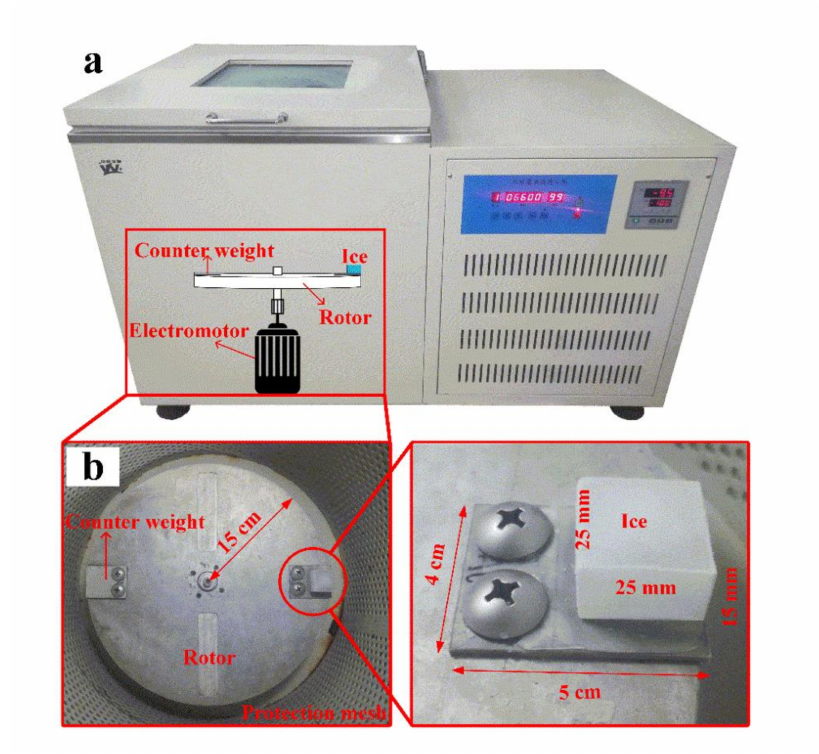
Figure 6. ( a ) Photographs of refrigeration centrifuge and ( b ) centrifuge test